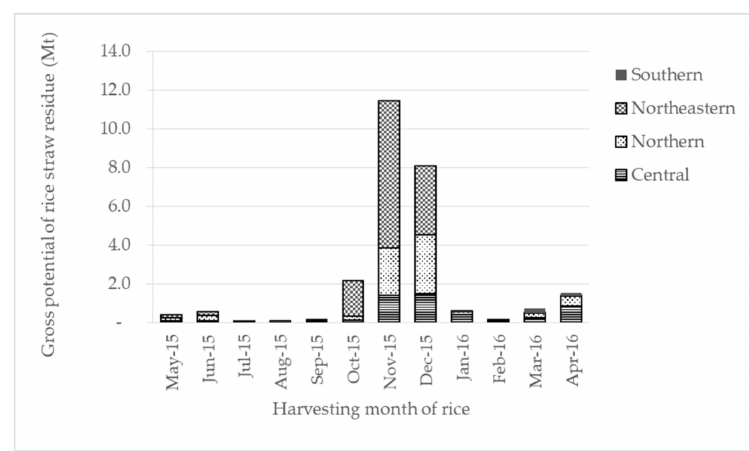
Figure 7. Regional and monthly temporal distribution of gross potential of rice